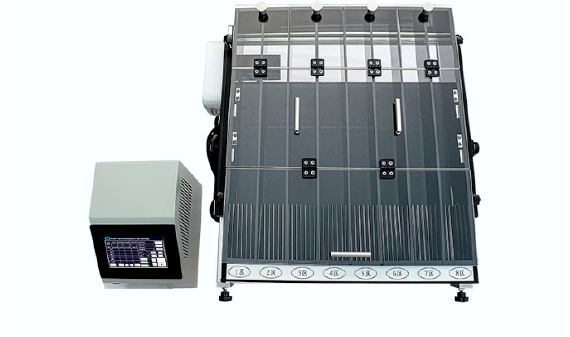
Figure 1. Treadmill setup .